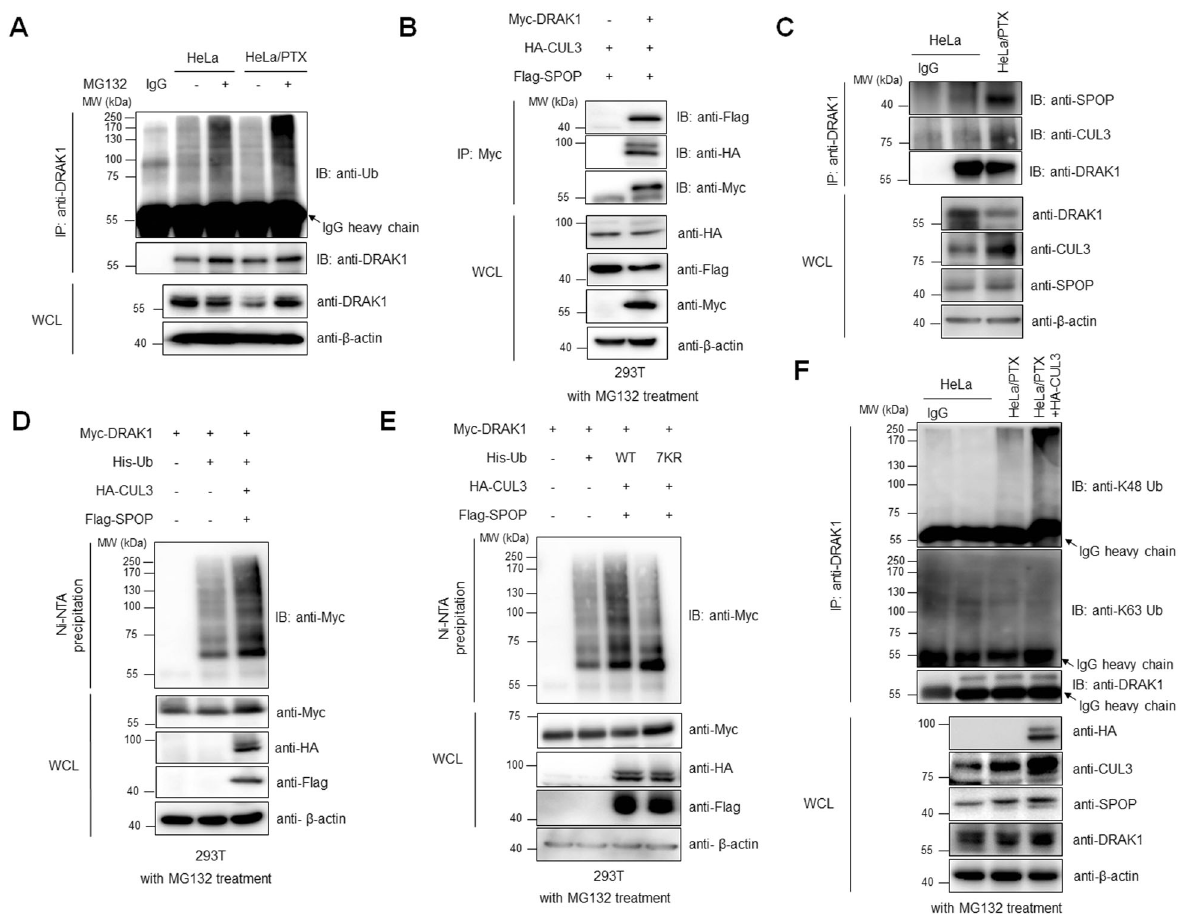
Fig. 6 DRAK1 is degraded through K48-linked polyubiquitination induced by CUL3/SPOP E3 ubiquitin ligase. A Immunoprecipitation assay showing endogenous DRAK1 ubiquitination in HeLa and HeLa/PTX cells upon MG132 (10 μ M) treatment for 6 h. B Immunoprecipitation assay showing the interaction of Myc-DRAK1 with HA-CUL3 and Flag-SPOP in 293 T cells. C Immunoprecipitation assay showing the endogenous interaction of DRAK1 with CUL3 and SPOP in HeLa and HeLa/PTX cells. D In vivo ubiquitination assay showing Myc-DRAK1 ubiquitination by cotransfection of HA-CUL3 and Flag-SPOP in 293 T cells with MG132 (10 μ M) treatment for 6 h. E In vivo ubiquitination assay showing Myc-DRAK1 ubiquitination by cotransfection of HA-CUL3 and Flag-SPOP in 293 T cells using Ni-NTA pull down of His-Ubiquitin WT or His-Ubiquitin 7KR mutant (mutating all seven lysines to arginines) with MG132 (10 μ M) treatment for 6 h. F Immunoprecipitation assay showing endogenous DRAK1 ubiquitin chain linkages. HA-CUL3 ectopically transfected in HeLa/PTX and indicated samples were immunoprecipitated with anti-DRAK1 antibody, followed by immunoblotting with anti-K48 Ub (K48-linkage speci fi c Ubiquitin) or anti-K63 Ub (K63-linkage speci fi c Ubiquitin) antibodies upon MG132 (10 μ M) treatment for 6